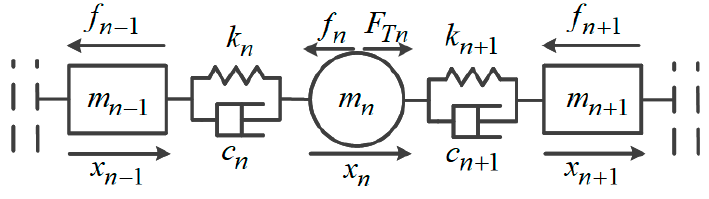
Figure 3. Dynamic model of roller motor n . Tension